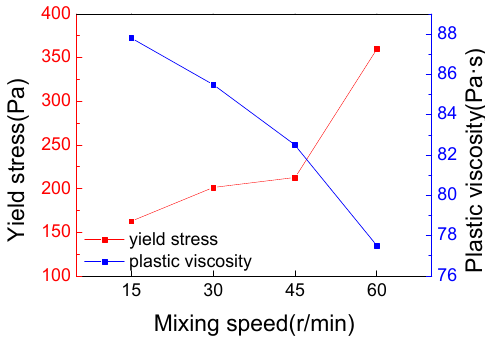
Figure 9. Effect of mixing speed on the rheological parameters of SCC. Figure 9. E ff ect of mixing speed on the rheological parameters of